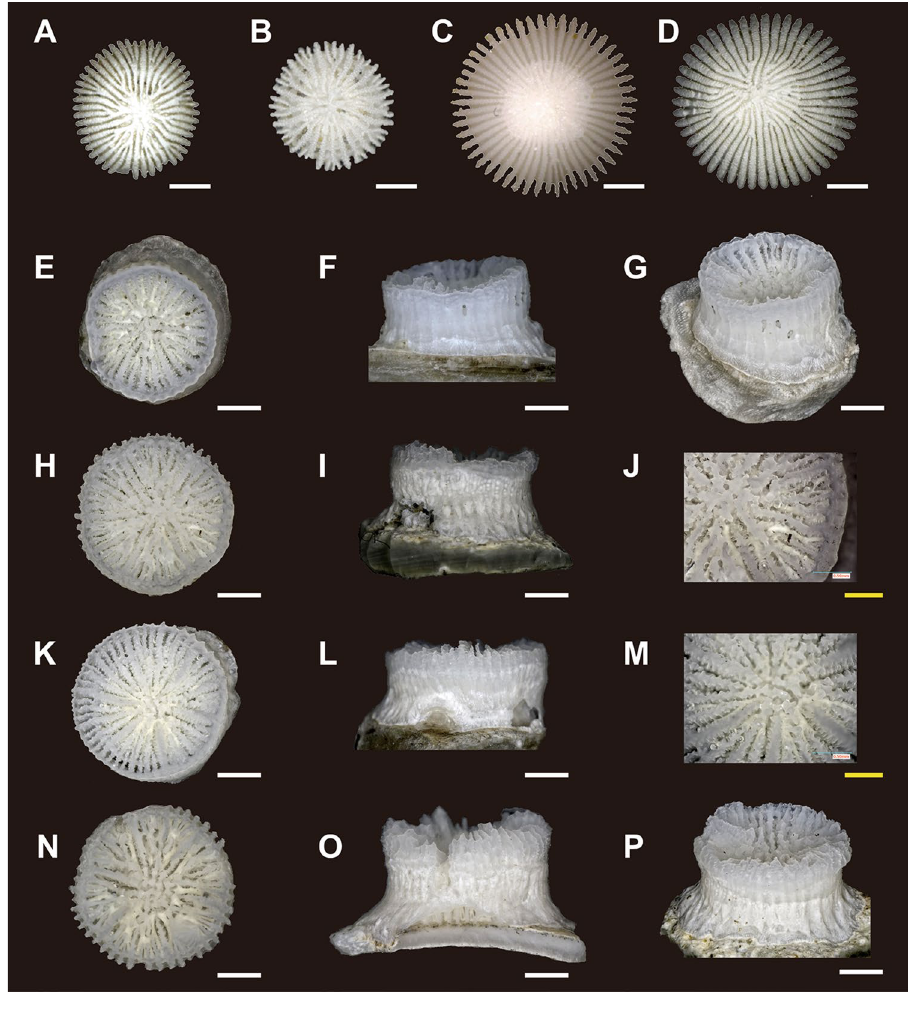
Figure 2. ( A – D ) Anthocyathi of Deltocyathoides orientalis with decalcification process scar. ( E – P ) oral (top), lateral, and other views of undescribed species (anthocauli of Deltocyathoides orientalis ). ( E – G ) 501 . ( H – J ) 503 . ( K – M ) 505 . ( N – P ) 507 . White scale bars = 1 mm, Yellow scale bars = 0.5